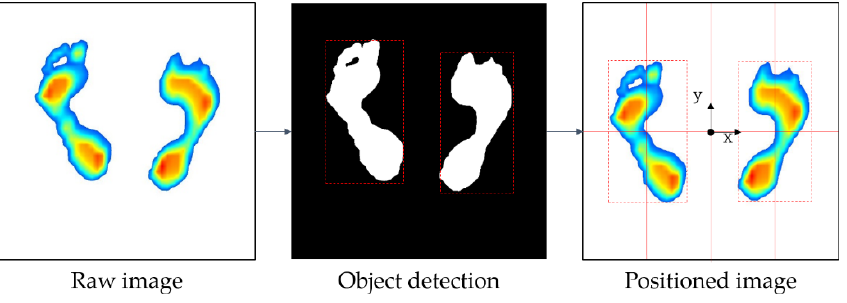
Figure 5. Image positioning method.